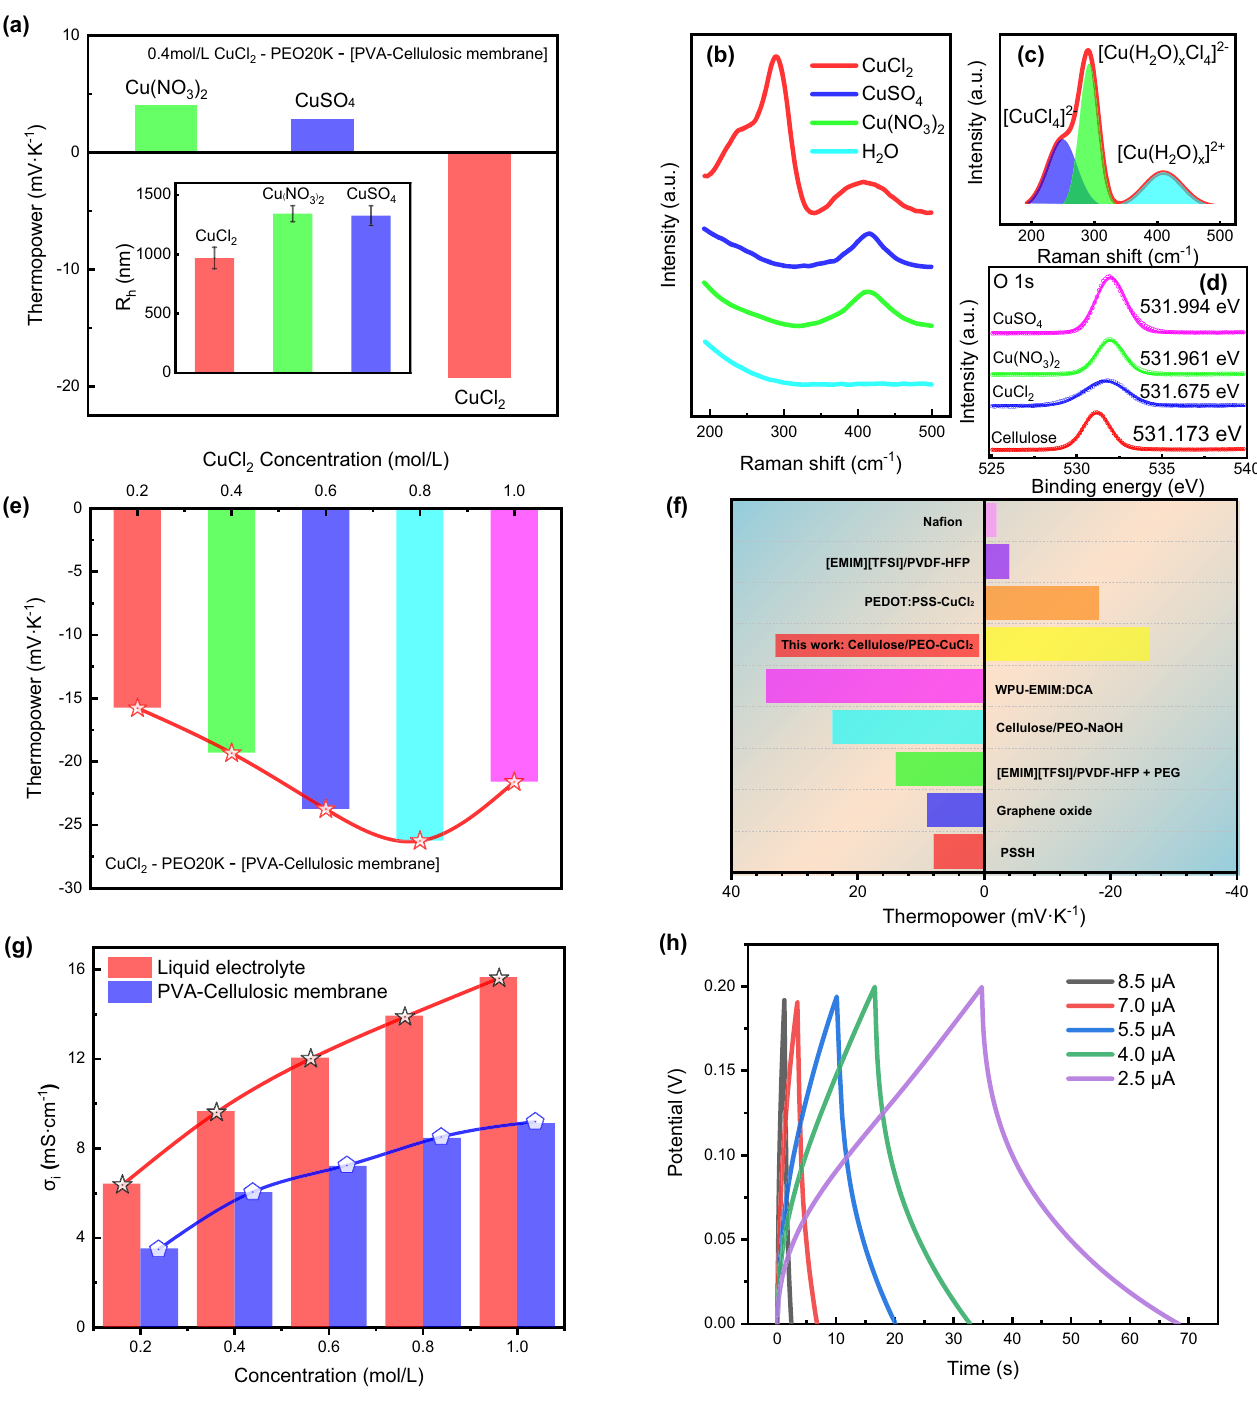
Fig. 4 Ion transport and regulation capabilities of PVA-cellulosic membranes. a Measured thermopowers of PVA-cellulosic membrane in fi ltrated with PEO aqueous solution of 0.4 mol/L Cu(NO 3 ) 2 , CuSO 4 and CuCl 2 . Hydrodynamic radius of Cu(NO 3 ) 2 -cellulose, CuSO 4 -cellulose and CuCl 2 -cellulose aqueous solutions were shown in the inset. b The Raman peaks representing Cu 2 + solvation con fi gurations of saturated Cu(NO 3 ) 2 , CuSO 4 and CuCl 2 aqueous solution. c) The fi tted peaks of saturated CuCl 2 aqueous solution. d High-resolution O 1 s photoelectron spectra of the Cu(NO 3 ) 2 -[PVA-cellulosic membrane], CuSO 4 -[PVA-cellulosic membrane] and CuCl 2 -[PVA-cellulosic membrane]. e Thermopowers of PVA-cellulosic membranes in fi ltrated by the CuCl 2 -PEO aqueous solution of different CuCl 2 concentration. f Thermopowers of the various i-TE materials (Supplementary Table 2). g The ionic conductivity of PVA-cellulosic membrane measured at different CuCl 2 concentrations. h The constant current charge-discharge curves of the PVA-cellulosic membrane in fi ltrated with CuCl 2 -PEO aqueous